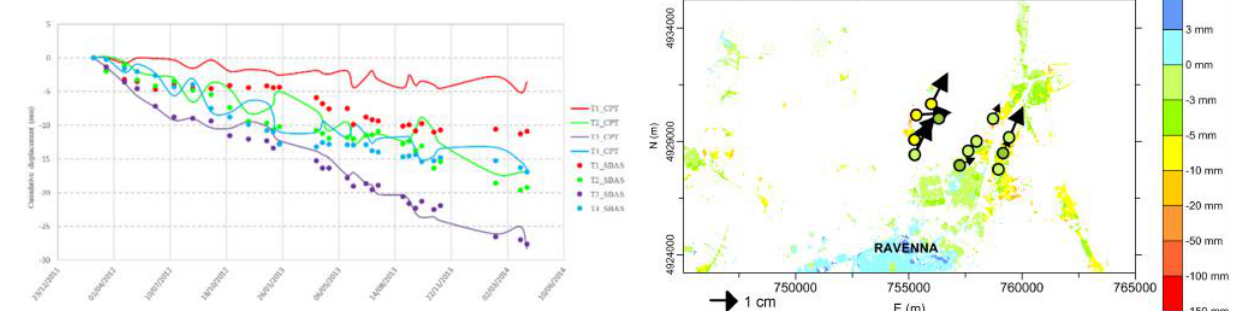
Figure 9. Comparison between the displacements obtained with GPS and SBAS